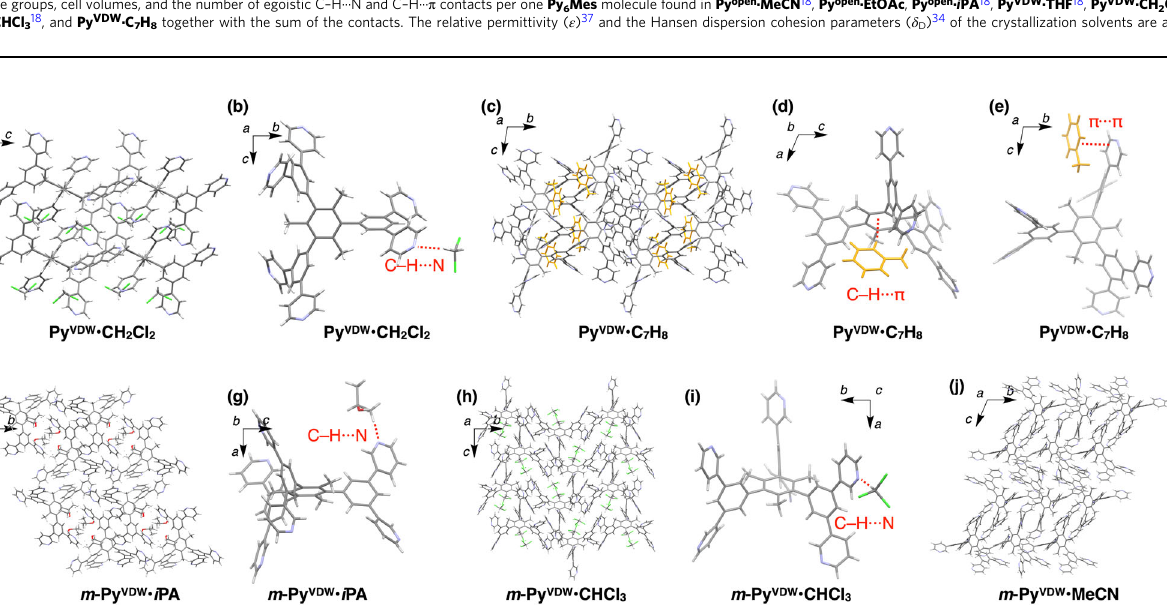
Fig. 3 Crystal packing diagrams of the polymorphs of Py 6 Mes and m -Py 6 Mes. a , c , f , h , j Crystal packing diagrams of Py VDW ·CH 2 Cl 2 ( a ), Py VDW ·C 7 H 8 ( c ), m -Py VDW · i PA ( f ), m -Py VDW ·CHCl 3 ( h ), and m -Py VDW ·MeCN ( j ). b , d , e , g , i Partial crystal structures of Py VDW ·CH 2 Cl 2 ( b ), Py VDW ·C 7 H 8 ( d,e ), m - Py VDW · i PA ( g ), and m -Py VDW ·CHCl 3 ( i ). The solvent – solute interactions are visualized with red dashed lines. The guest toluene molecules are colored in orange for